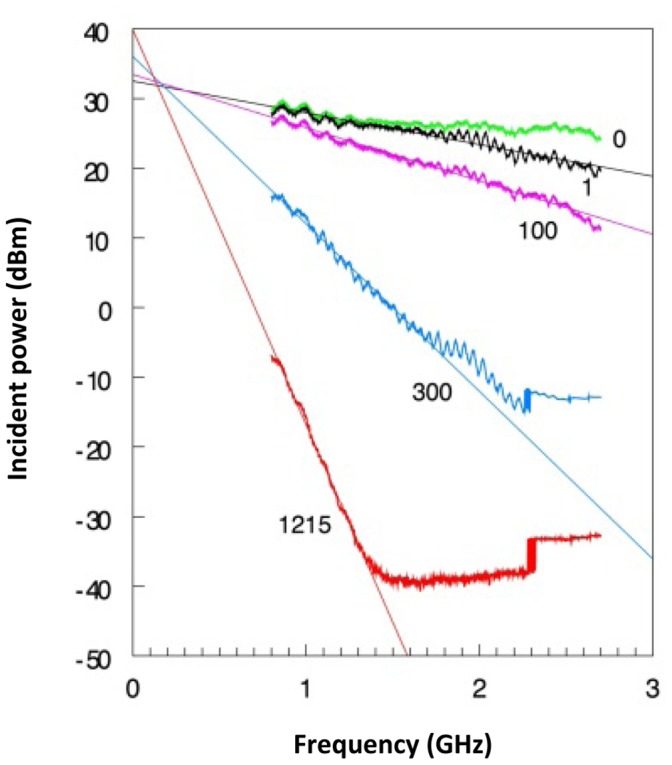
Power loss versus frequency in water-filled cells of different length.All cells were made of silicone tubing (4 mm o.d., 2 mm i.d.) with 1 mm diameter copper wire inner conductor (as in Fig. 6). Power from the VNA incident to the broadband amplifier was set at −30 dBm or, for the two longest cells, at −20 dBm. The three upper traces were shifted vertically over +10 dB to normalize all traces to −20 dBm incident power. The output power of the cells were measured with the broadband power meter. The green trace (0 cm) is for no cell and reflects losses in the brandless elongation cables of 1.5 m each. The black trace (1 cm) additionally shows losses due to impedance mismatch at the cell’s ends. Each trace was collected in circa 15 min as 1024 9-times averaged data points in the 0.8–2.7 GHz range.